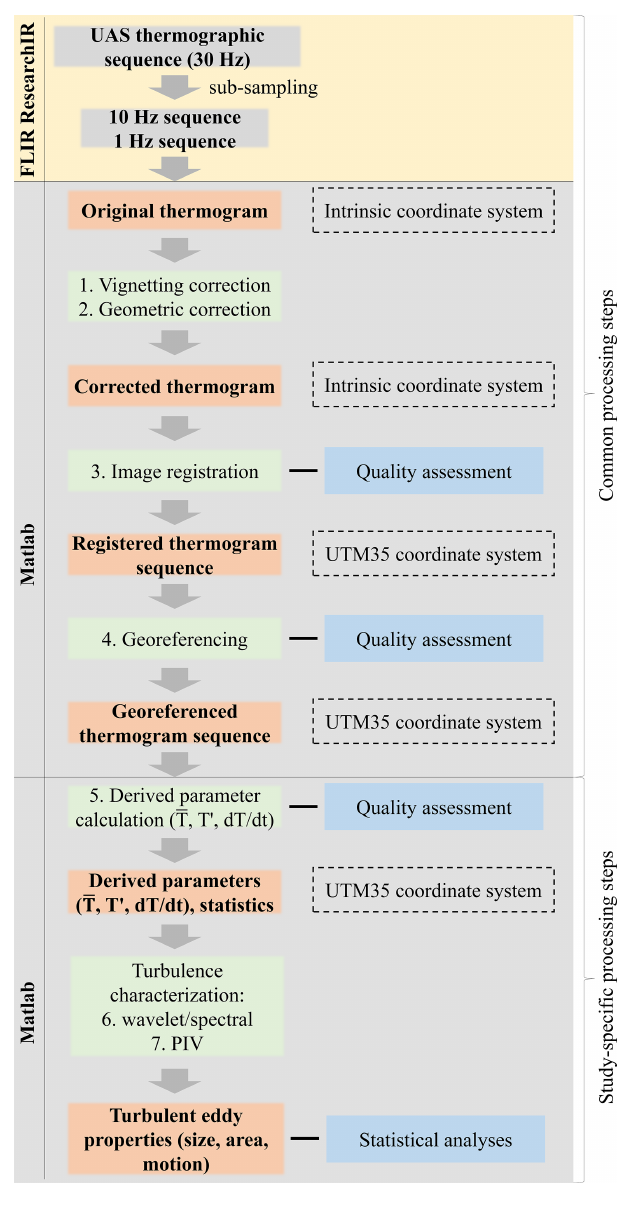
Figure 2. Data processing workflow. The workflow is divided into the stages executed with ResearchIR and MATLAB. Common pro- cessing steps are of general applicability to thermal video analysis, while the study-specific steps serve the aims of the current work. The processing steps numbered 1–7 are shown in green boxes and their output in orange boxes. Quality assessment steps and the coor- dinate system used at each step are shown in the righthand column.